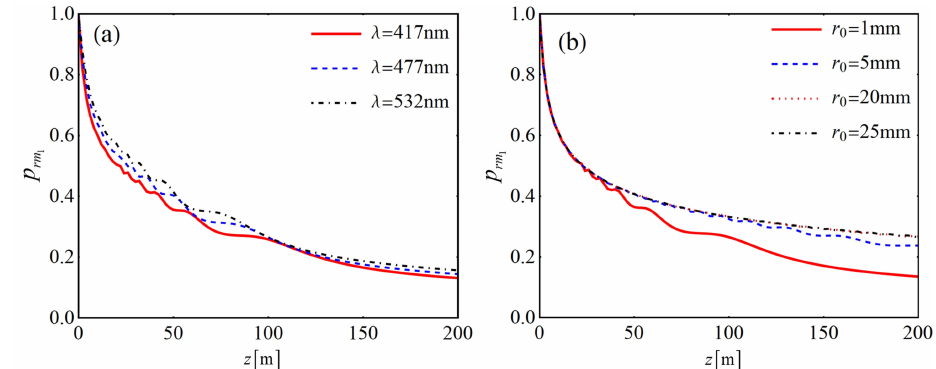
Figure 5. Relative detection probability of signal photon versus propagation distance for different ( a ) wavelengths λ and ( b ) main ring radius r 0 .